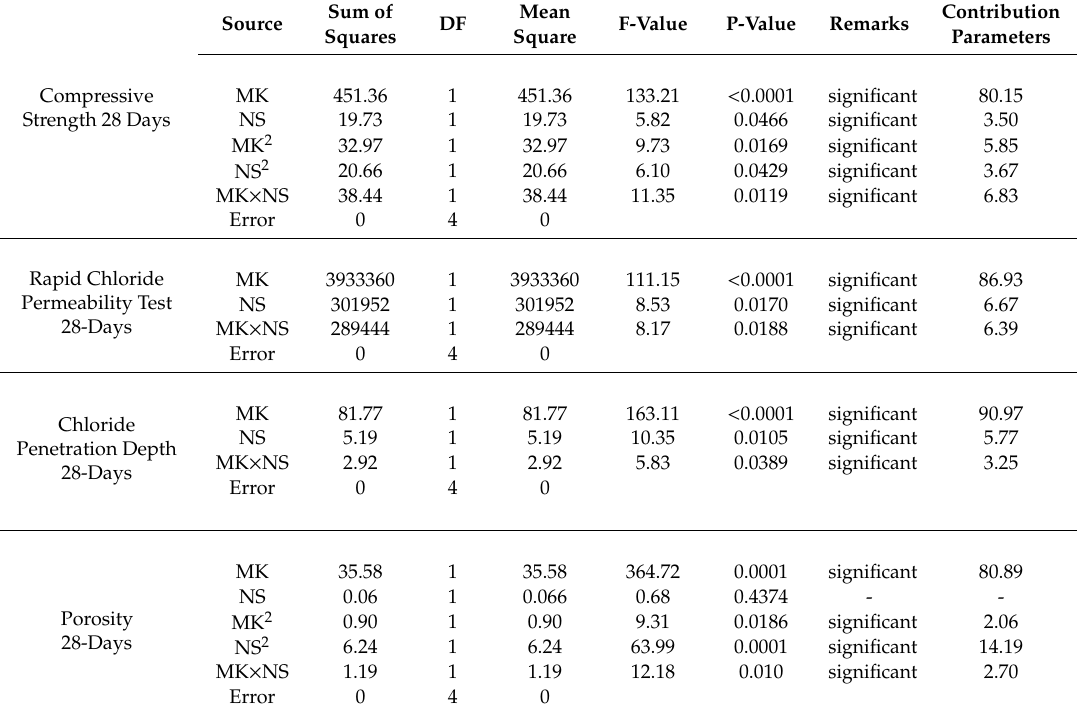
Table 4. Analysis of variance results for concrete